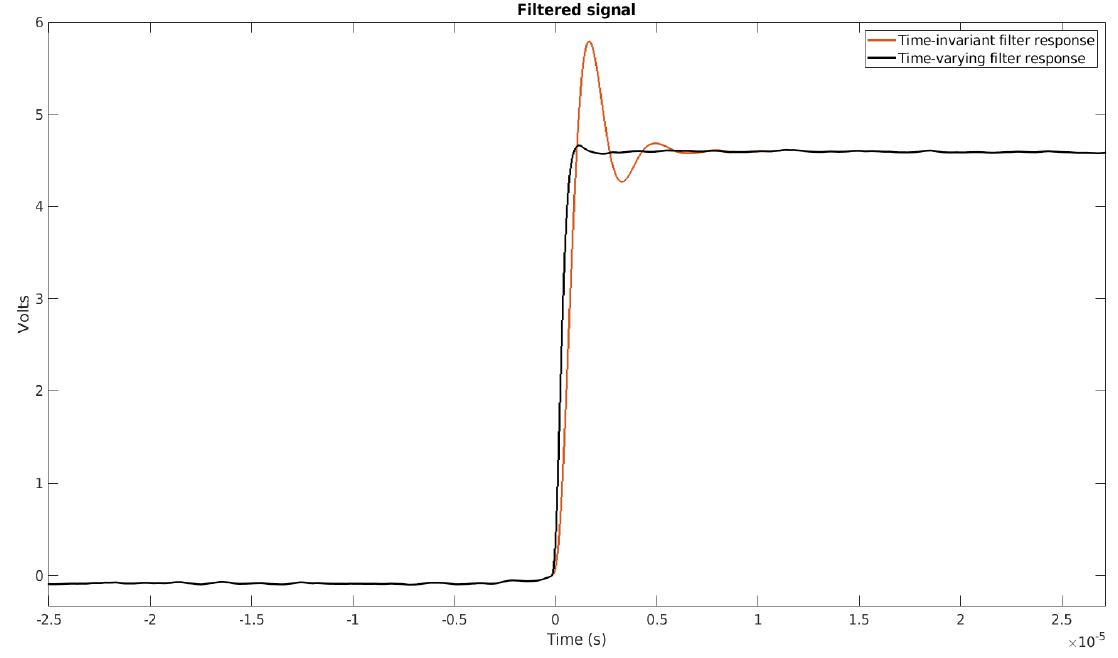
Figure 12. Closeup of the